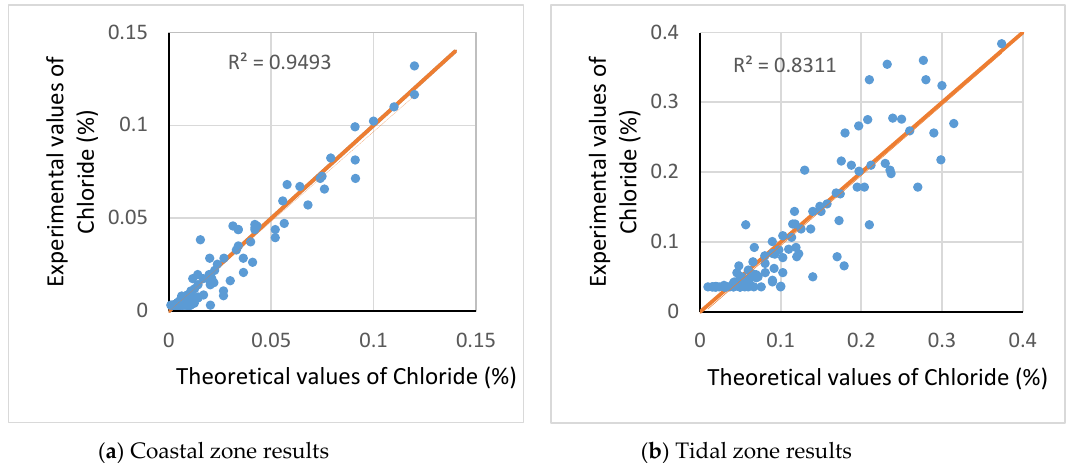
Figure 10. Regression analysis of the theoretical results of the transport model using the new binding model against experimental results. ( a ) Results from blocks located in coastal zone, ( b ) Results from blocks located in tidal zone.